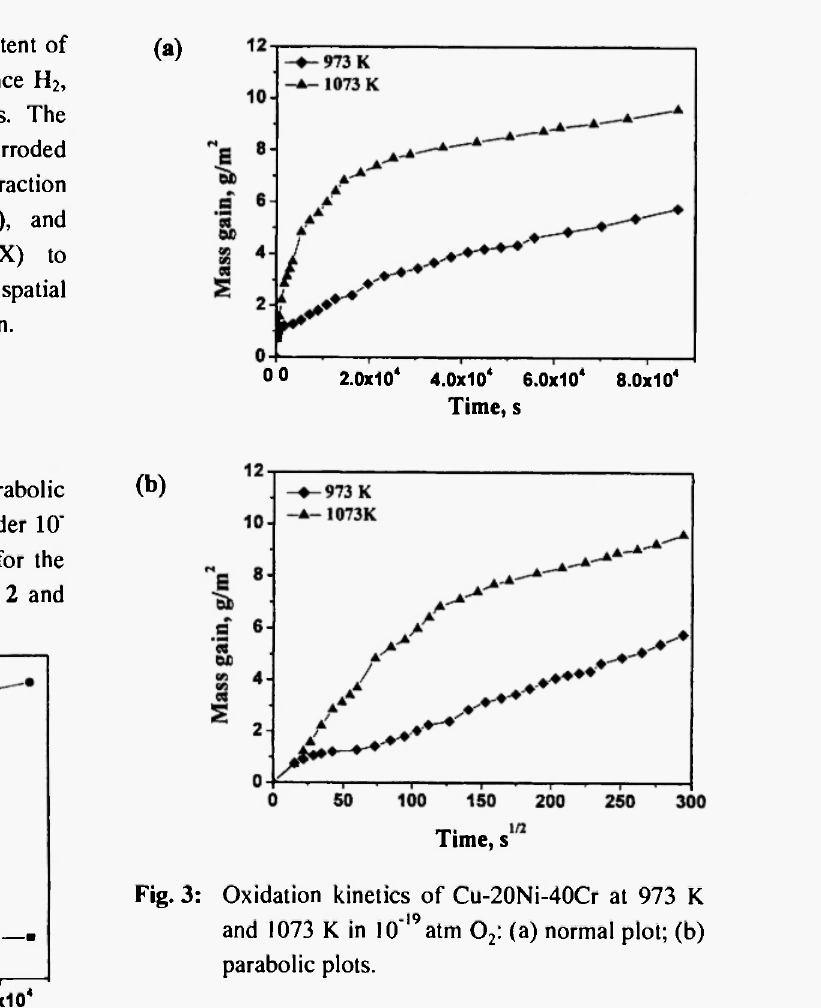
Fig.3, respectively. The kinetic measurements,